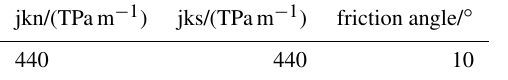
Table 9. Constitutive parameters for interfaces.